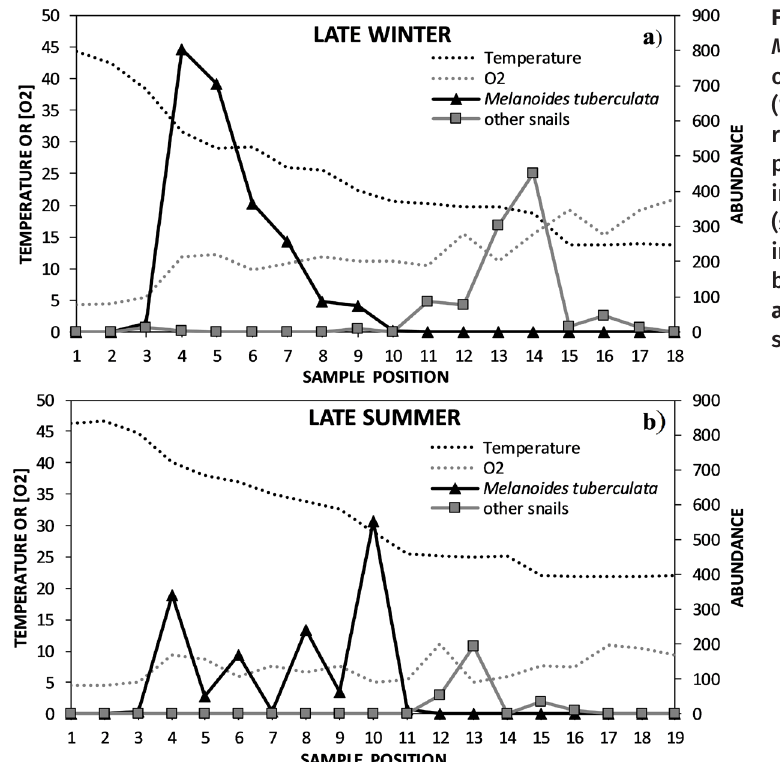
Figure 3. Abundance of Melanoides tuberculata and other snails, temperature (°C) and oxygen levels (mg.l -1 ) recorded in two samplings performed in Bahía Blanca in an excavated channel (samples 1-14) that discharges in the Napostá Grande stream between sites 16 and